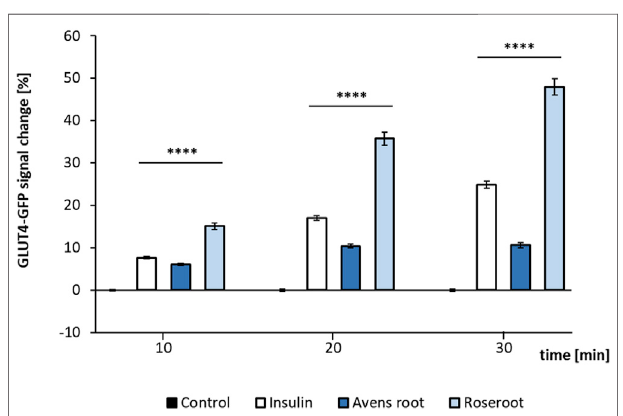
Frontiers in Pharmacology |